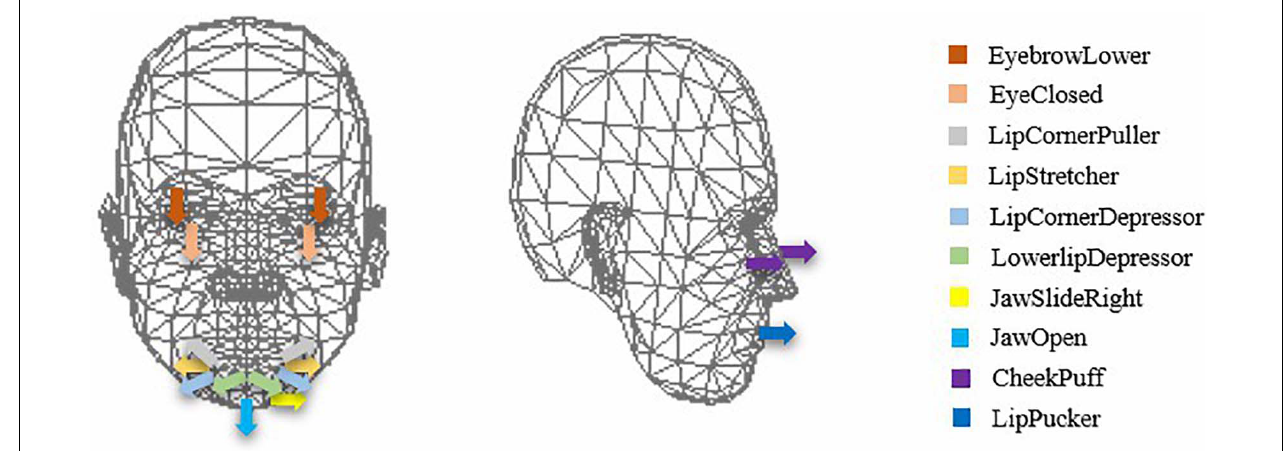
FIGURE 2 | The schematic diagram of each AU.